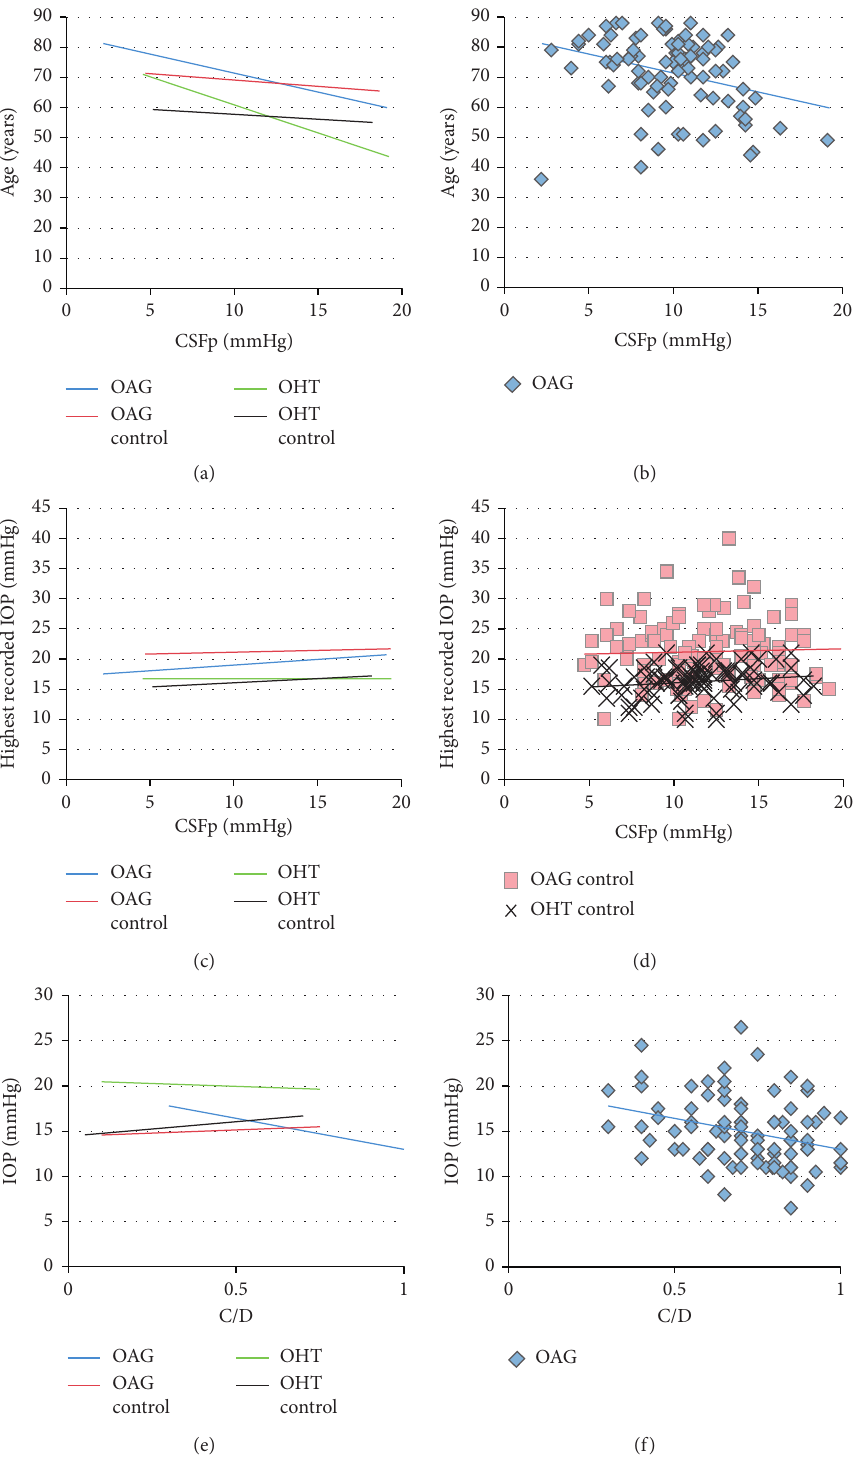
Figure 3: Linear regression analysis. (a, b) Analysis of age vs. CSFp showed a significant negative correlation in the OAG group. There was a negative relationship in all groups, but only the OAG group achieved significance. (c, d) Analysis of the average highest recorded IOP vs CSFp showed a significant positive correlation in both control groups. Significance was not achieved in either OAG or OHT cases. (e, f) Assessment of the IOP recorded closest to the date of lumbar puncture vs C/D showed a significant negative correlation in the OAG group. OHTtrended towards a negative relationship, while controls trended towards a positive correlation, but none of these achieved